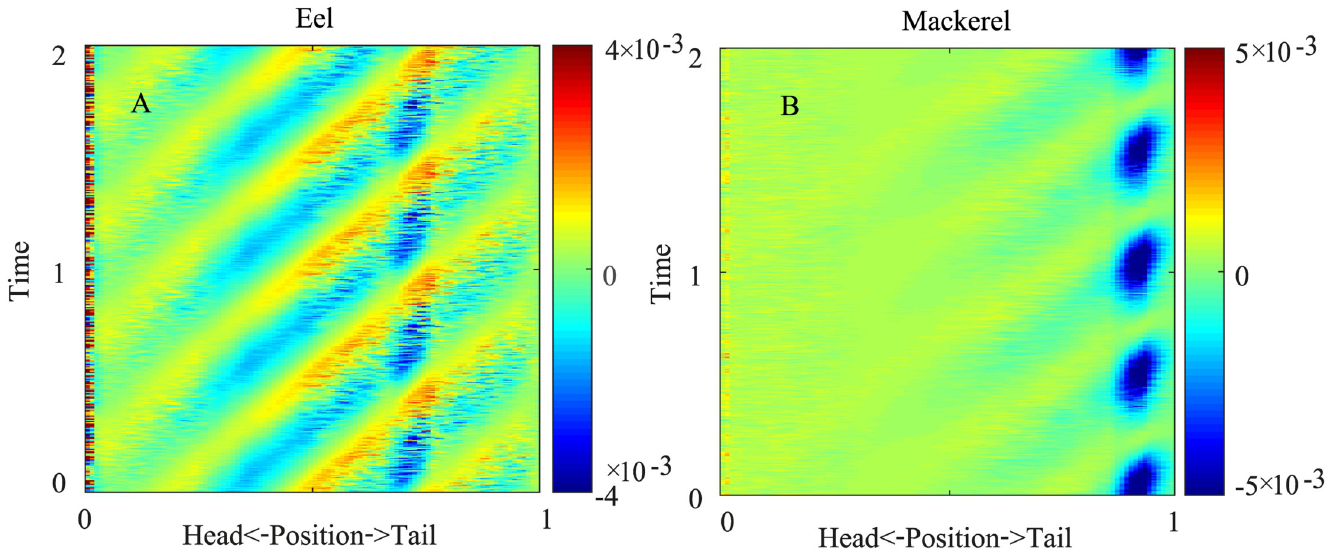
Fig 2. Spatiotemporal distribution of the fore-aft force ( F swimming direction is in the - x direction.